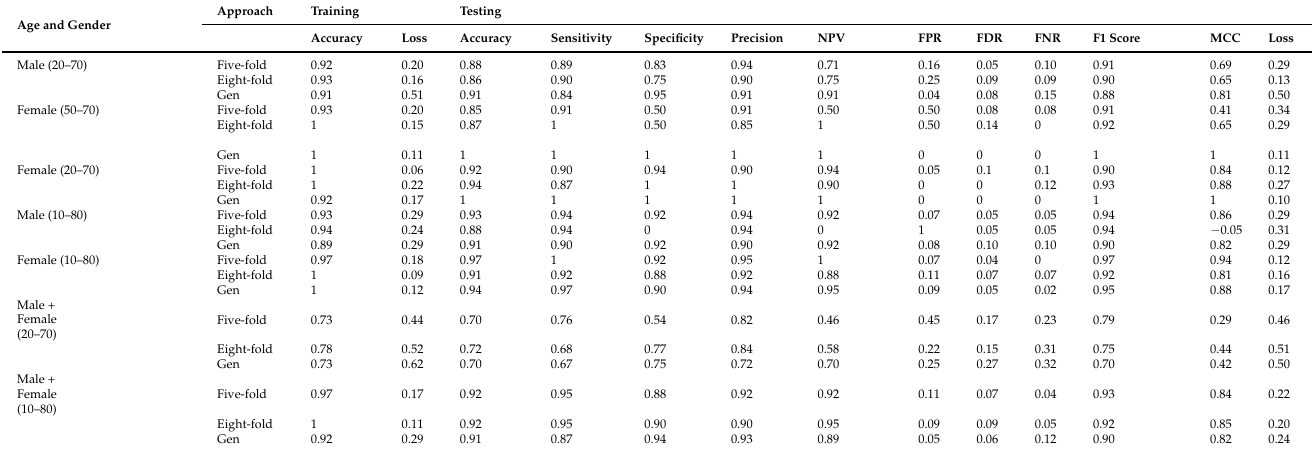
Table 9. LIM using age and gender (Gen = Generalization approach).